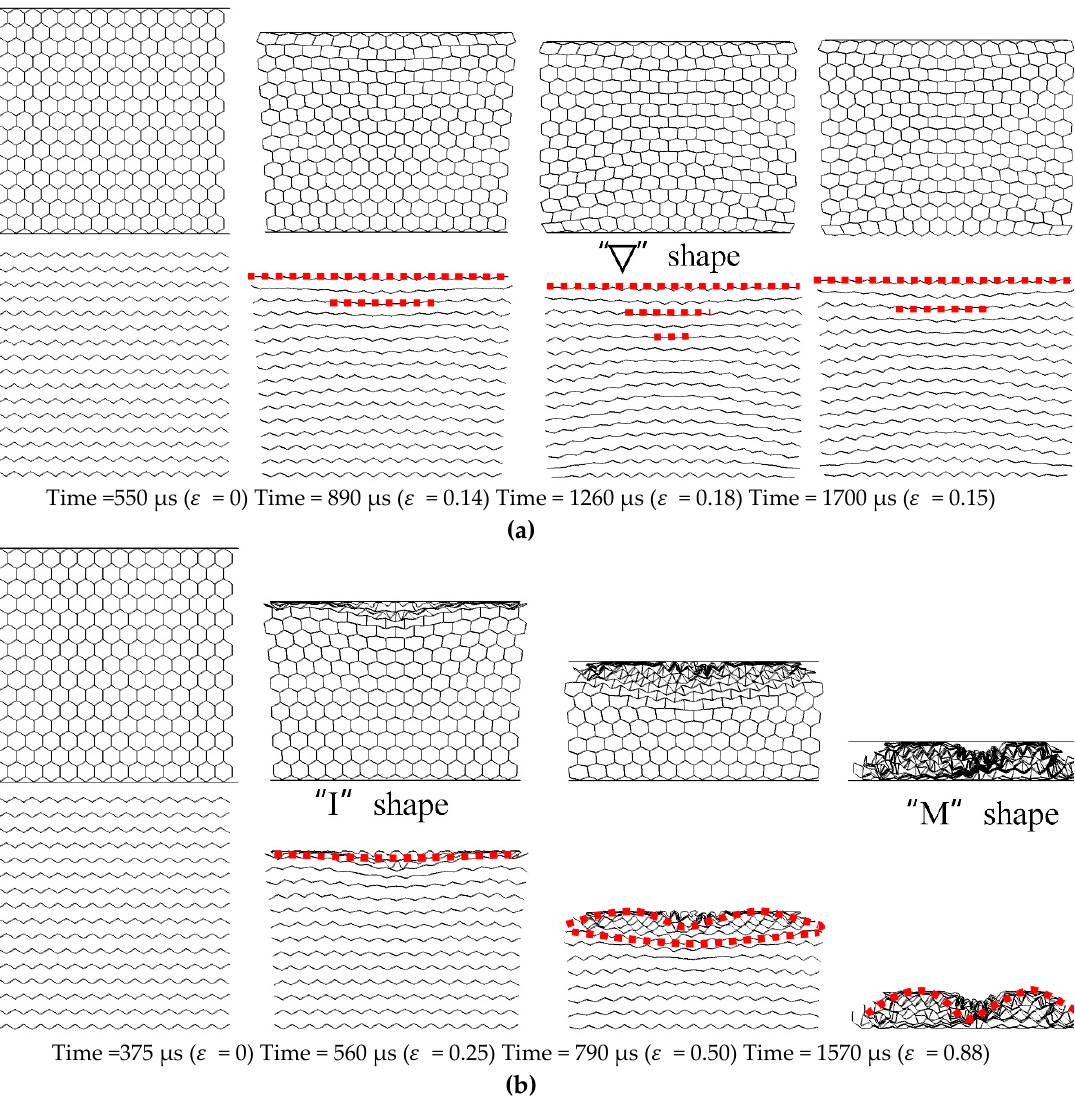
Figure 6. Deformation modes in the X2 -RP-H-RP, (a) Expansion mode and (b) Local inner concave mode.